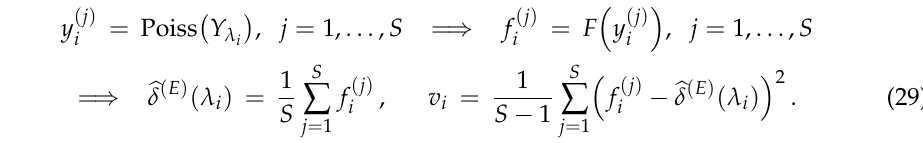
Figure 3. Visual representation of the first 34 terms of the sequence of coefficients γ in (26) ( left ) and the behavior of the probability measure defined in (28) as a function of λ ( right